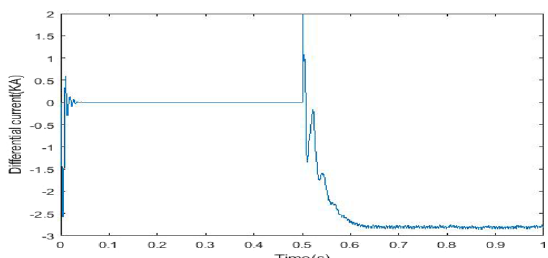
Fig. 9 PN and ground fault on HVDC line at 25 km